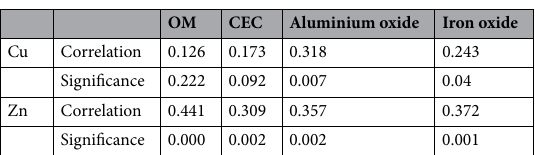
Table 9. Correlation between sediment components and adsorption